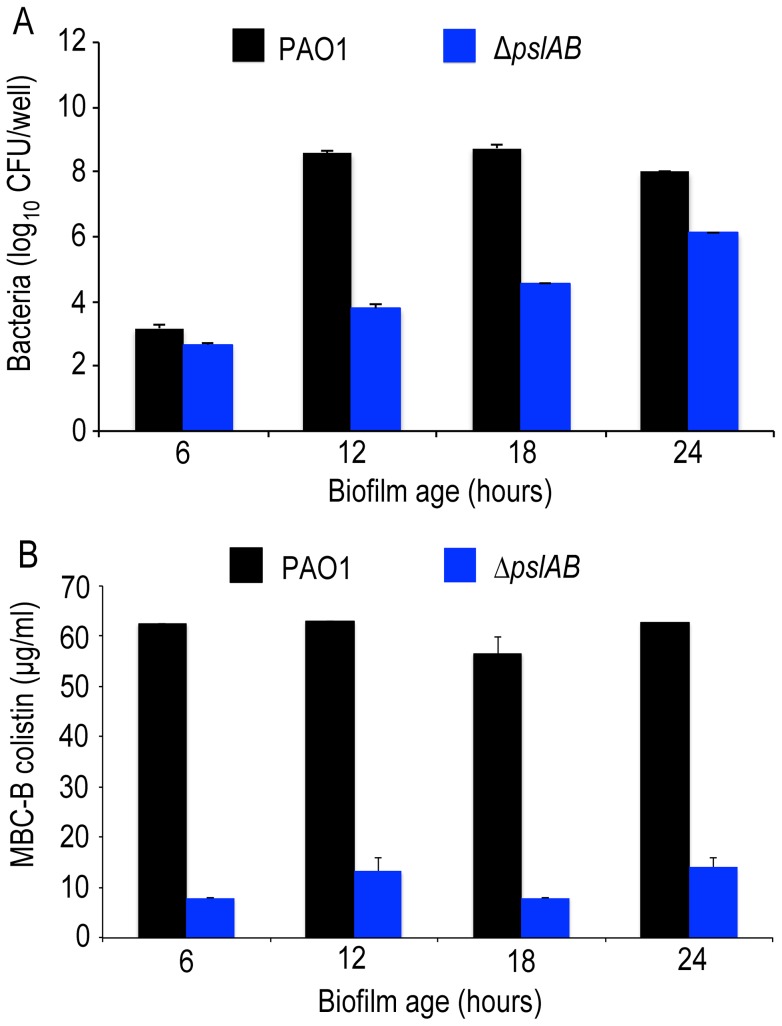
Psl protection is independent of biofilm age up to 24 hours.(A) Cell number count for WT PAO1 and ΔpslAB at 6, 12, 18, and 24 hours in biofilm development (B) The MBC-B of WT PAO1 and ΔpslAB at 6, 12, 18, and 24 hours suggest that sensitivity to antibiotics was the result of modulating the matrix and not a consequence of cell number in immature biofilms. Error bars represent SEM (n = 3).